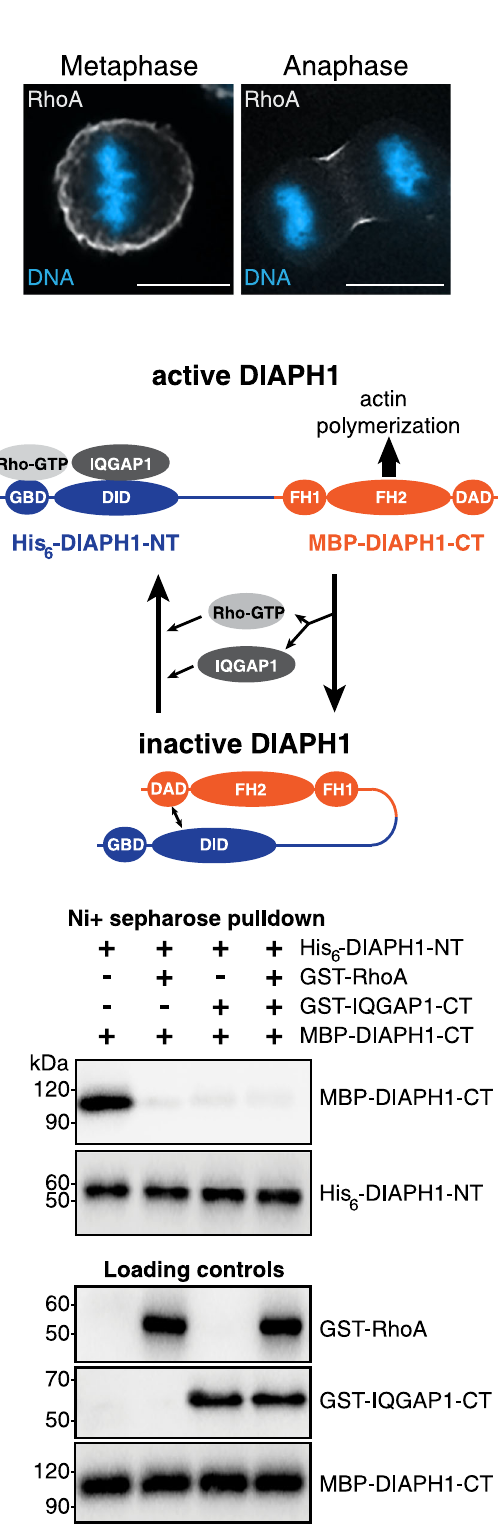
Fig. 5 Deactivation of DIAPH1 requires loss of binding to RhoA and IQGAP1. a HeLa cell fi xed and probed with an antibody recognizing RhoA, white and DAPI stained chromosomes in blue. b Preformed complexes of His 6 -DIAPH1-NT with GST-RhoA, GST-IQGAP1 or both prevent MBP-DIAPH1-CT binding to His 6 -DIAPH1-NT. Schematic depicts that DIAPH1 deactivation requires the removal of both RhoA and IQGAP1. CT =